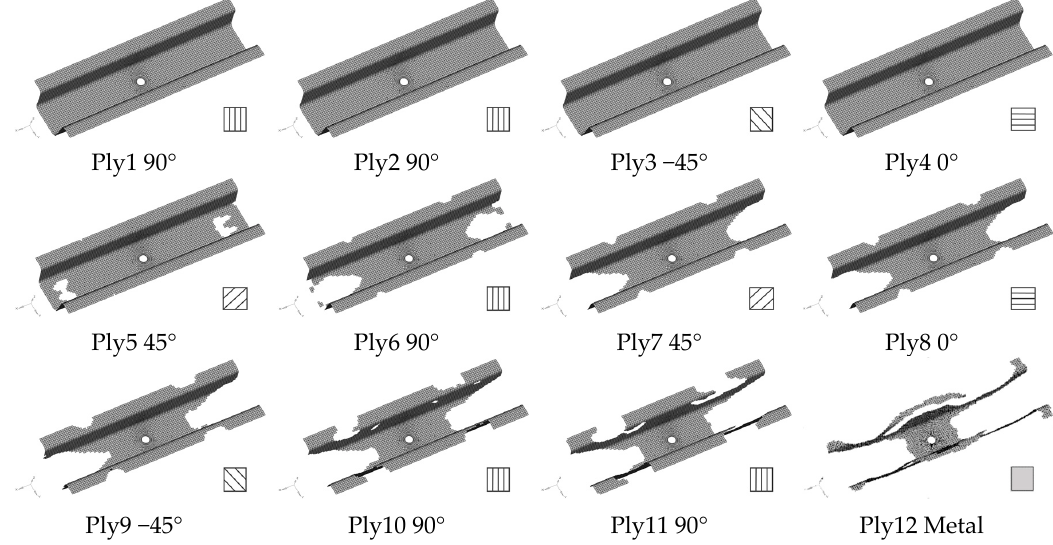
Figure 4. Optimized layout of each CFRP layer of the battery-hanging beam.